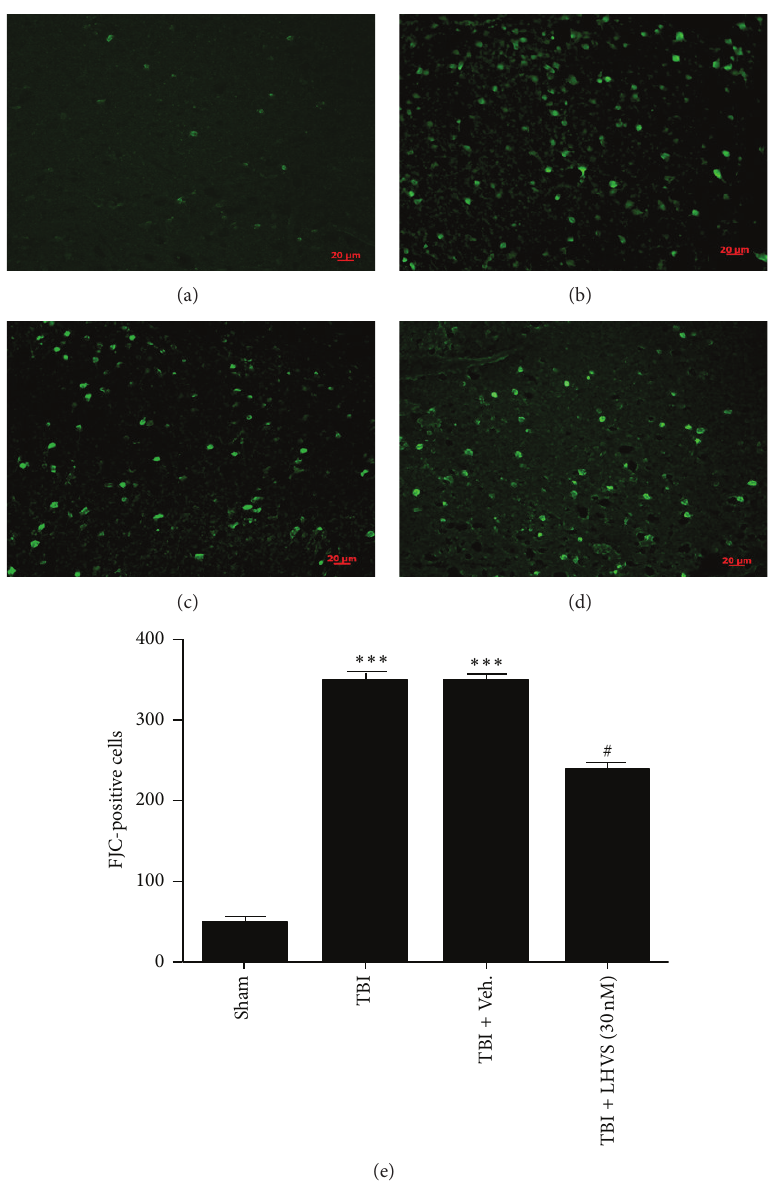
Figure 7: LHVS pretreatment reduces neuronal degeneration after traumatic brain injury (TBI). Upper panel: Fluoro-Jade C (FJC) staining of the pericontusional cortex in the sham group (a), TBI group (b), TBI + vehicle group (c), and TBI + LHVS (30nM) group (d). Bottom panel: quantification of neurodegenerating (FJC-positive) cells in each group ( 𝑛 = 6 mice per group). Pretreatment with 30 nM LHVS significantly reduced the number of degenerating neurons at 24 h after TBI. Vehicle treatment had no effect. Data are presented as mean ± SEM ( 𝑛 = 6 ). ∗∗∗ 𝑃 < 0.001 versus sham group; # 𝑃 < 0.05 versus TBI + vehicle group. Scale bar: 20 𝜇